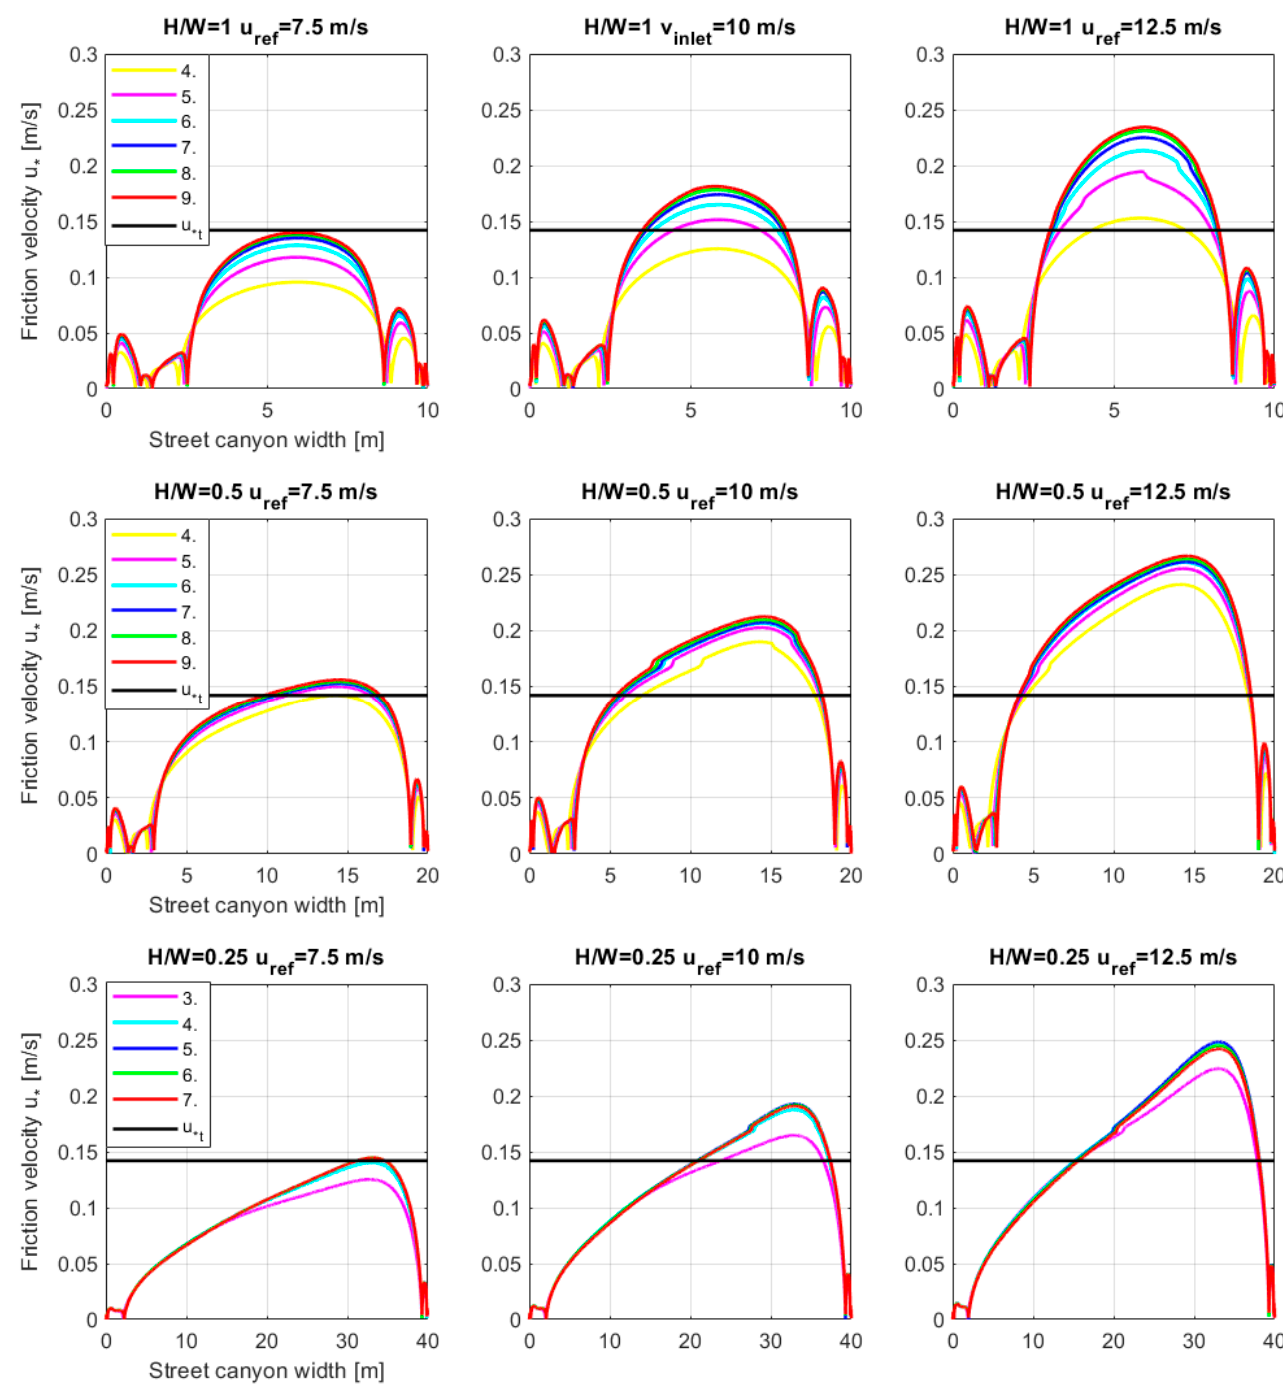
Figure 2. Friction velocity profile in a particular street canyon (indicated by a sequence number) in the street canyon array. Different geometry and flow configurations are displayed. The threshold friction velocity u ∗ t is also displayed.